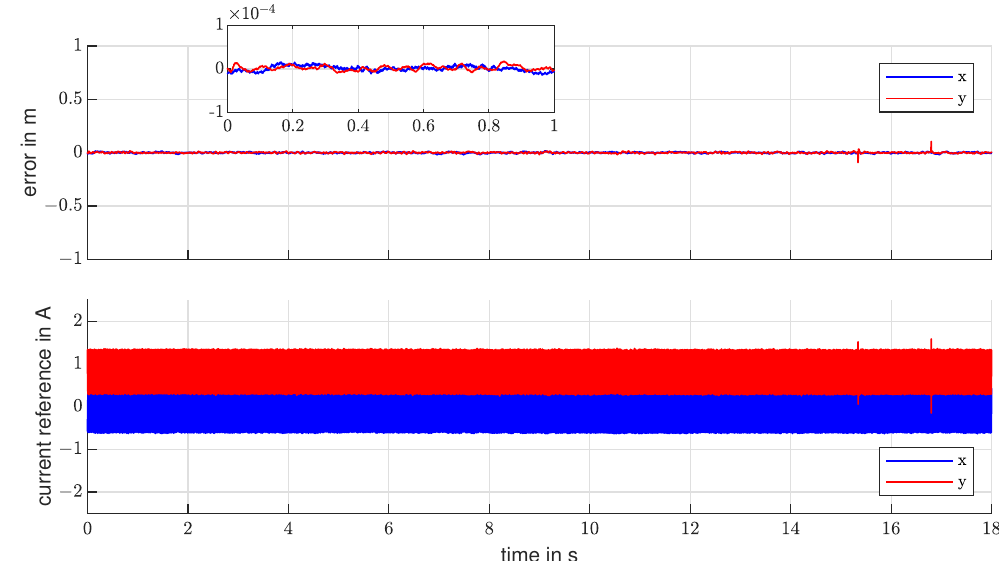
Figure 12. Displacement error and current reference i ∗ with current controller dynamics for one single AMB with constant reference positions.